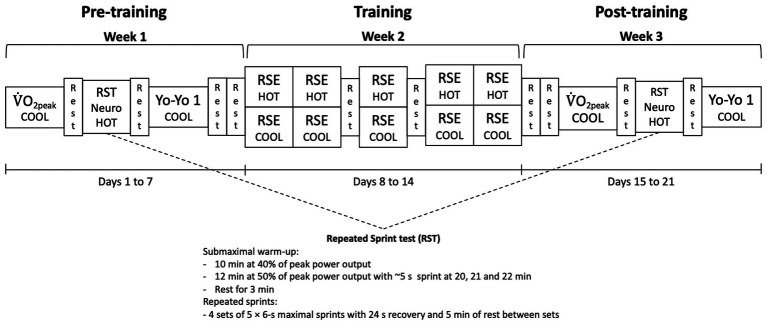
Experimental overview of the repeated-sprint exercise (RSE) training protocol undertaken by separate groups in either HOT (40°C and 40% RH) or COOL (20°C and 40% RH) conditions, as well as the pre‐ and post-training assessments performed in conditions as indicated. V˙O2peak, peak oxygen consumption test; RST, repeated-sprint test; Neuro, neuromuscular function assessment; and Yo-Yo 1, intermittent recovery test level 1.